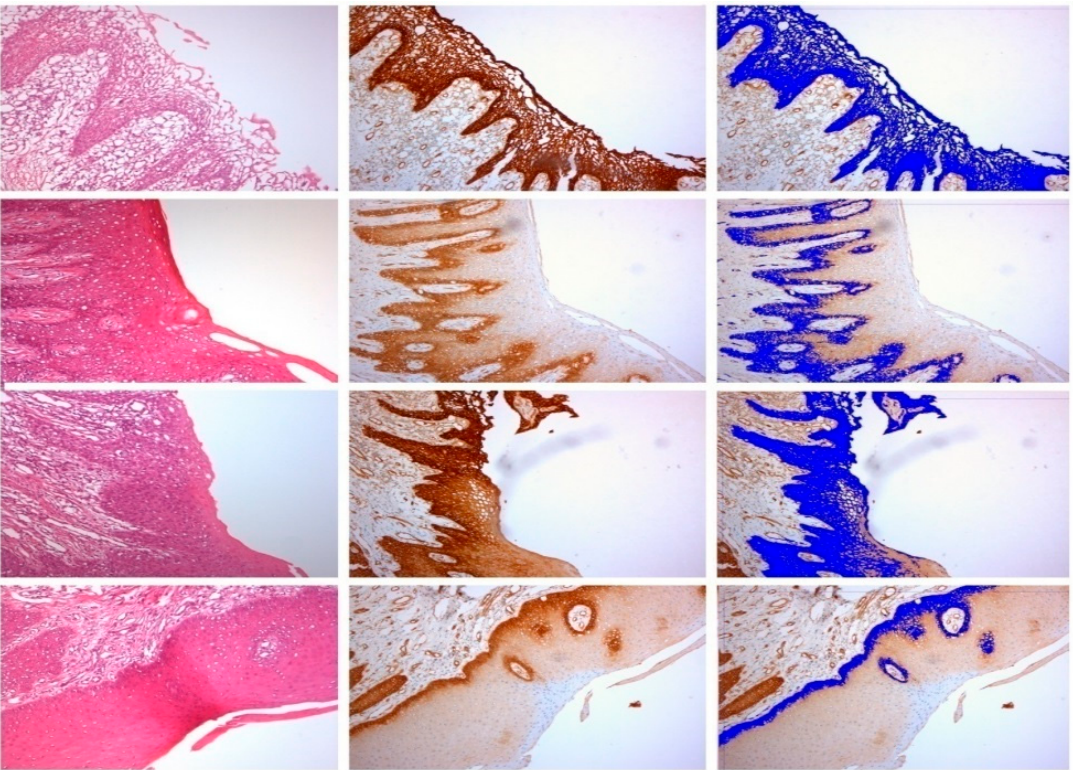
Figure 2. Immunohistochemical expression of integrins. From the top to bottom: T1, T2, T3, T4. The left column shows H&H stain; the second one represents the Integrin alpha6 expression (strep-ABC—Streptavidine–Biotine–Peroxidase); the right column shows software analysis.